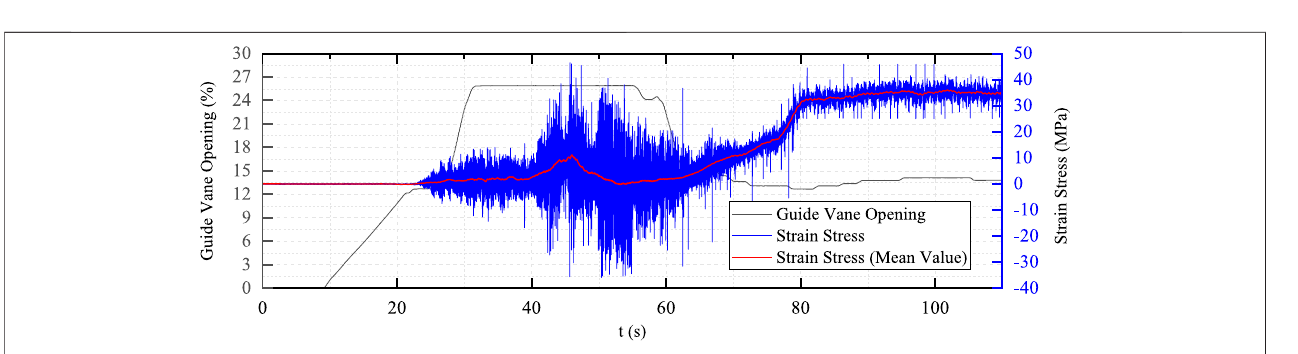
FIGURE 12 | The stress curve of the blade back in the direction of vertical water fl ow (two-stage acceleration).